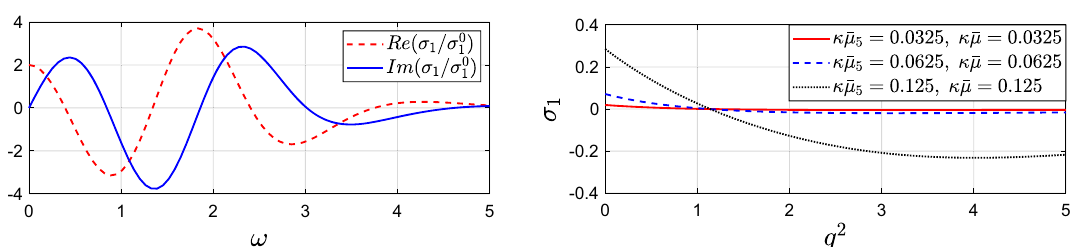
Fig. 14 ω -dependence of σ 1 /σ 0